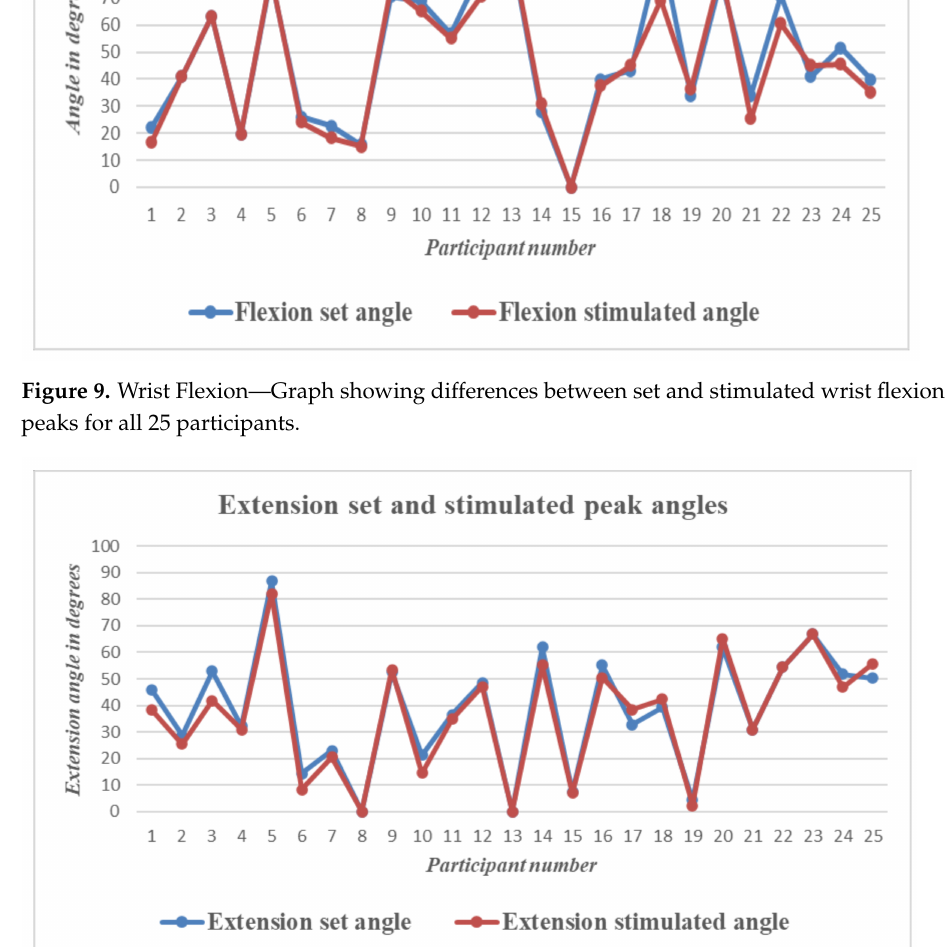
Figure 10. Wrist Extension—Graph showing differences between set and stimulated wrist extension angle peaks for all 25